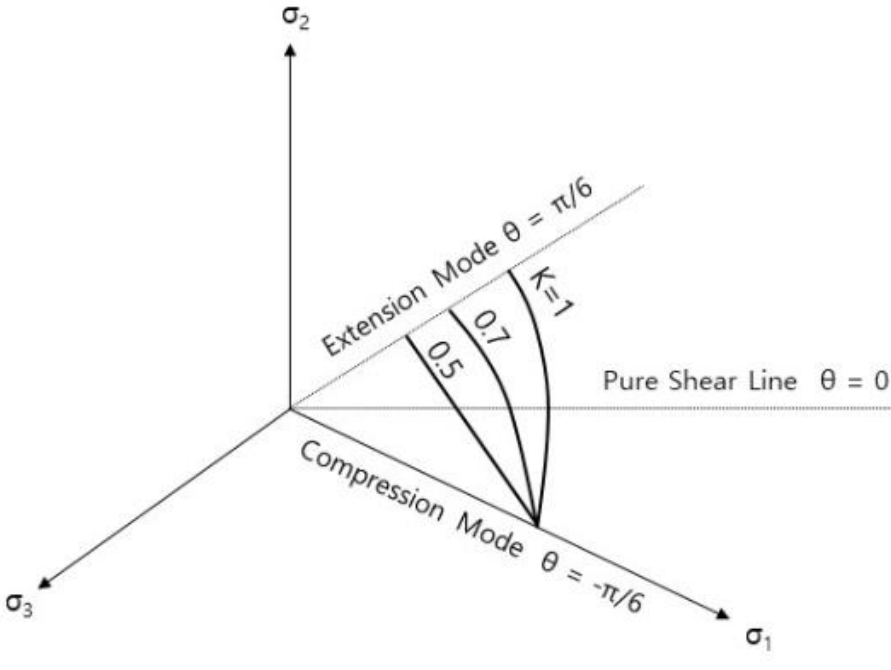
Figure 6. Triaxial compression and extension modes in an octahedral plane.